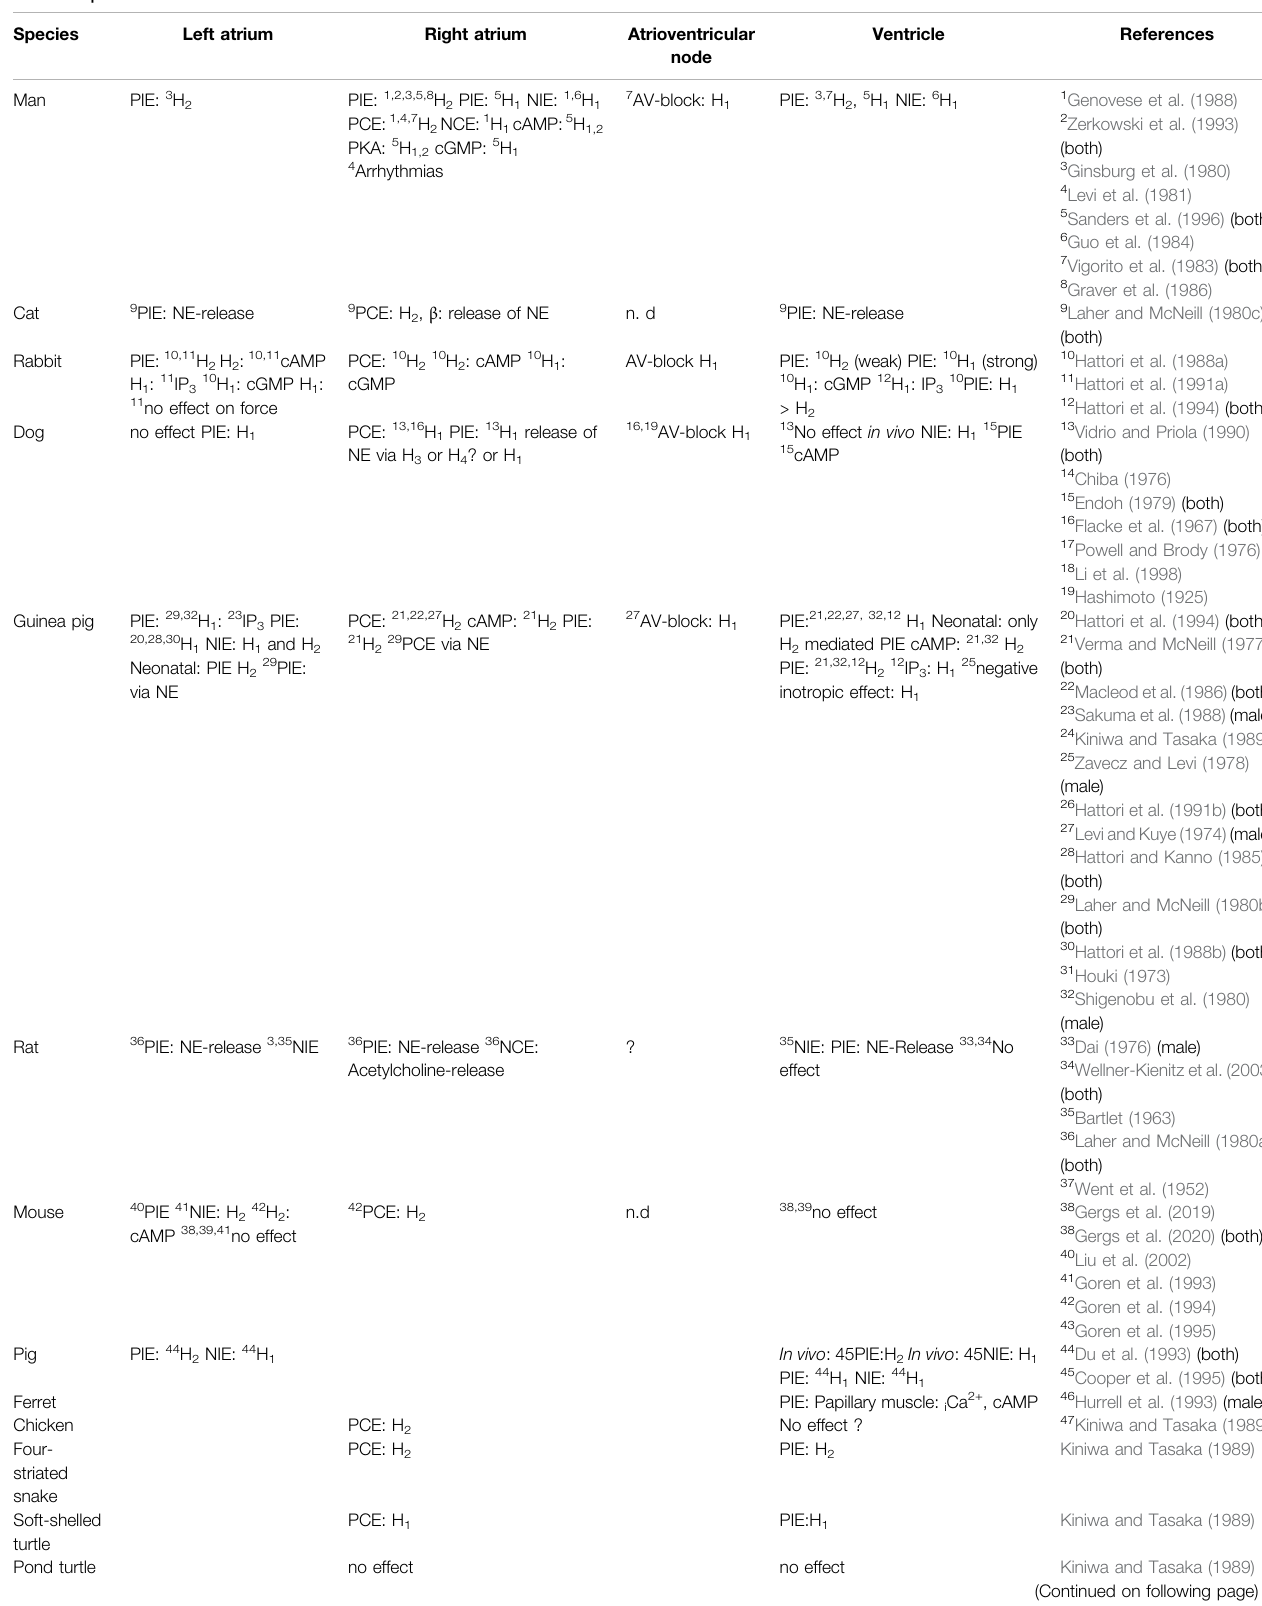
TABLE 4 | Cardiac effects of